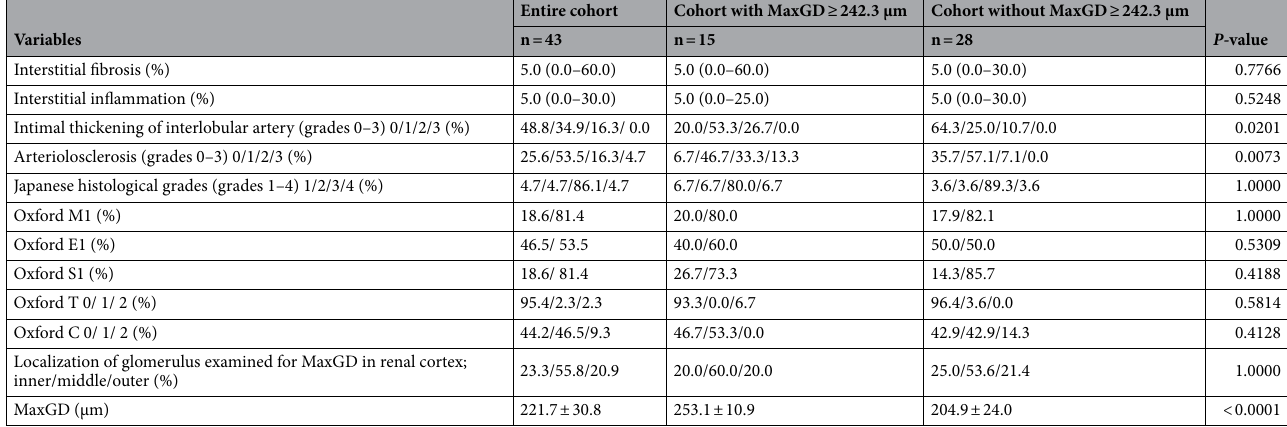
Table 1. Patient characteristics according to the presence of MaxGD ≥ 242.3 μm: Clinical, laboratory, and pathological findings. Continuous variables are expressed as means ± standard deviation or median (minimum–maximum). Count data are expressed as %. For the variables with missing data, the number of patients with non-missing data are shown in []. Abbreviations: MaxGD, maximal glomerular diameter; n, number; BW, body weight, BMI, body mass index; %, percentages; SBP, systolic blood pressure; DBP, diastolic blood pressure; MBP, mean blood pressure; PP, pulse pressure; WBC, white blood cells; eGFR, estimated glomerular filtration rate; IgG, immunoglobulin G; IgA, immunoglobulin A; IgM, immunoglobulin M; C3, complement component 3; C4, complement component 4; U-Prot, Urinary protein excretion; U-RBC, urinary red blood cells; HPF, high-power field; IBW, ideal body weight; GBM, glomerular basement membrane; M, mesangial hypercellularity; E, endocapillary hypercellularity; S, segmental glomerulosclerosis; T, tubular atrophy/interstitial fibrosis; C, cellular/fibrocellular crescents.